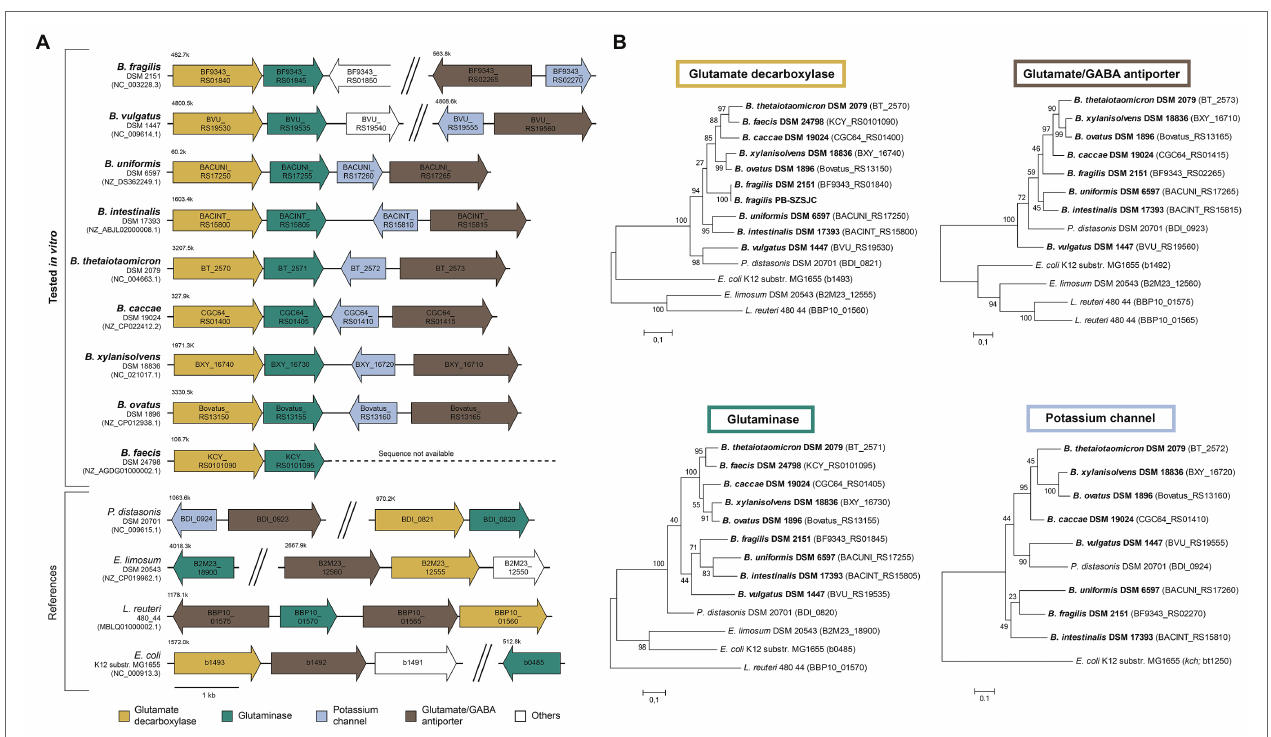
FIGURE 2 | Genetic characteristics of the glutamate decarboxylase (GAD)-system in Bacteroides strains. (A) Genetic organization of the GAD-system genes (i.e., glutamate decarboxylase, glutaminase, glutamate/GABA antiporter, and potassium channel) in Bacteroides strains tested in vitro compared to distinct GABA-producing taxa. (B) Phylogenetic trees based on GAD-system genes sequences. Trees were generated using the Maximum Likelihood method and the Jukes-Cantor correction model with 1,000 bootstraps. The strains screened in vitro are in